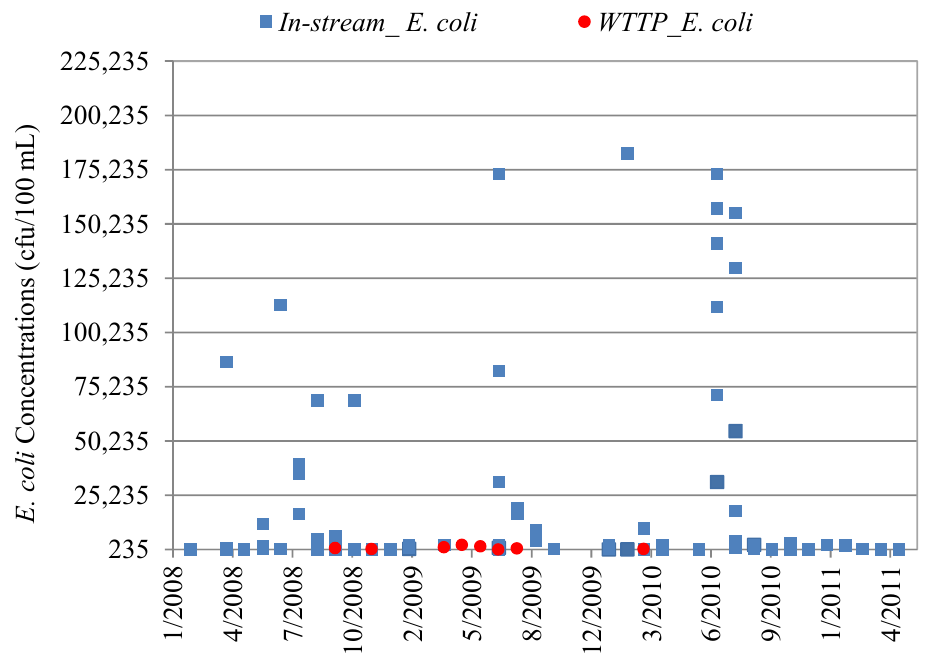
Figure 6. Comparison of E. coli from WWTP effluent discharge to in-stream sampling locations. Only values exceeding the 235 cfu/100 mL standard are shown.